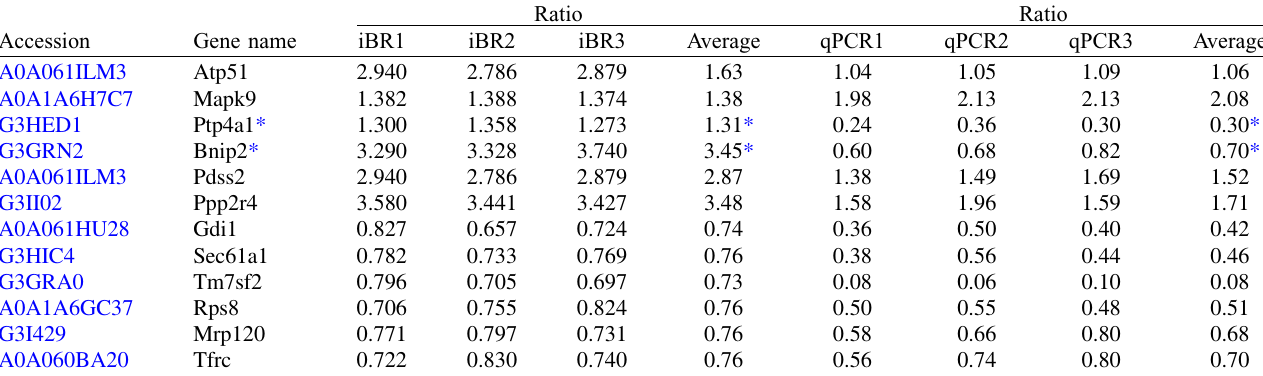
Table 2. Fold changes in the mRNA expression of 12 genes differently expressed in BHK cells infected with Eimeria tenella , detected by